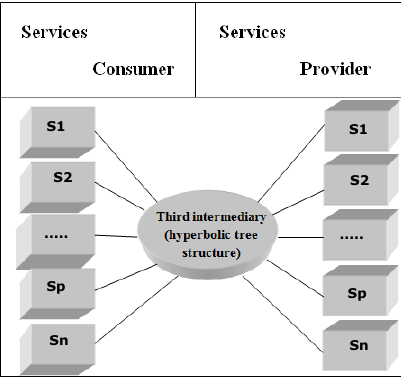
Figure 2. Service access’s architecture.